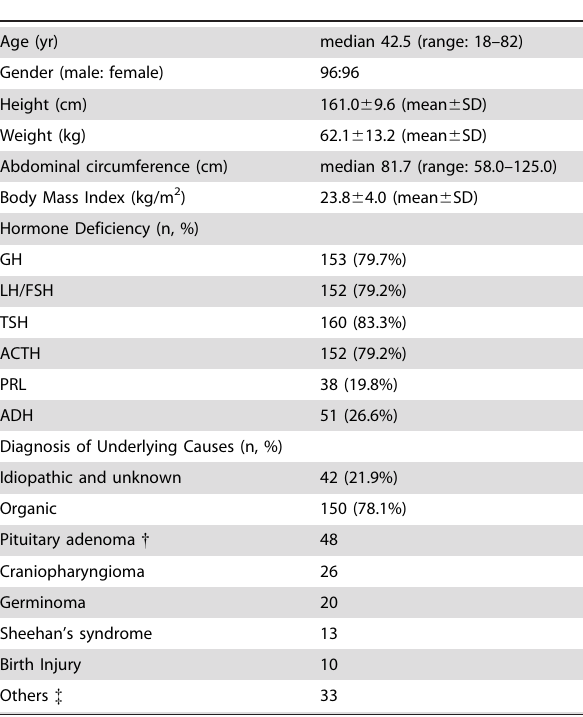
Table 1. Clinical characteristics of psychometric validation cohort